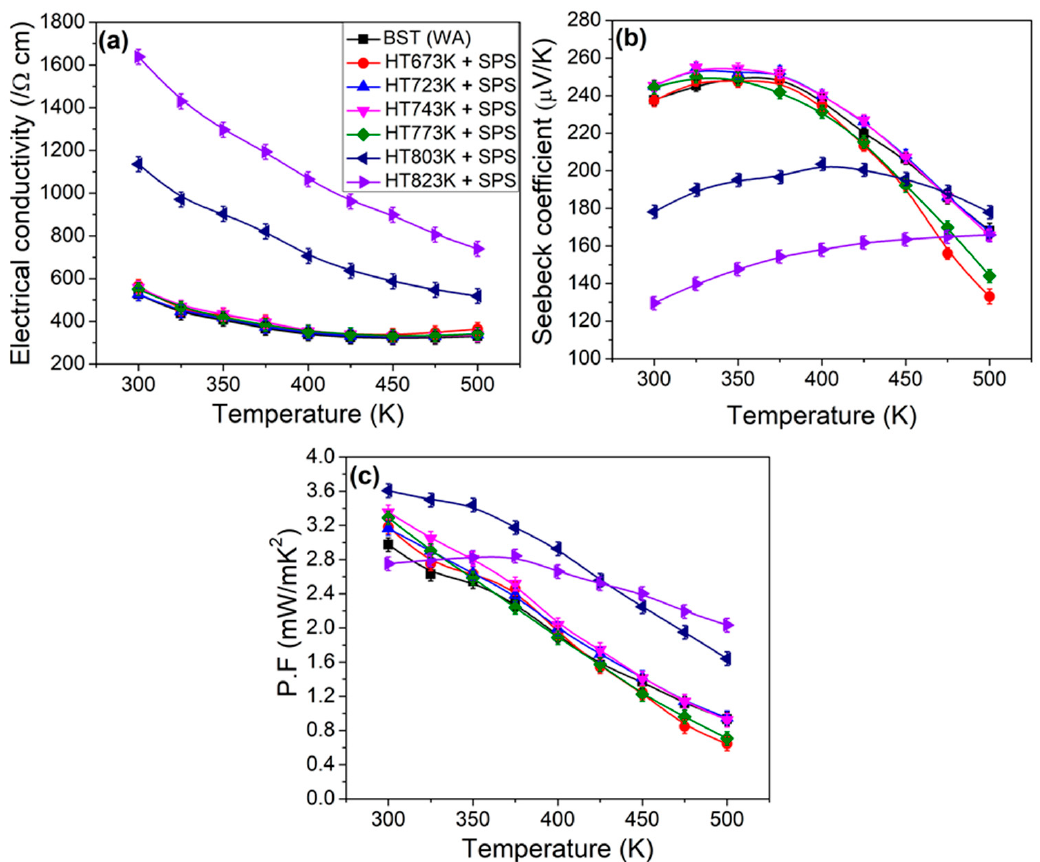
Figure 4. Temperature dependence of electrical transport properties for the bulk samples obtained by powder heat treatment at different temperatures and consolidation: ( a ) Electrical conductivity ( σ ), ( b ) Seebeck coefficient ( S ), and ( c ) Power factor ( PF ).